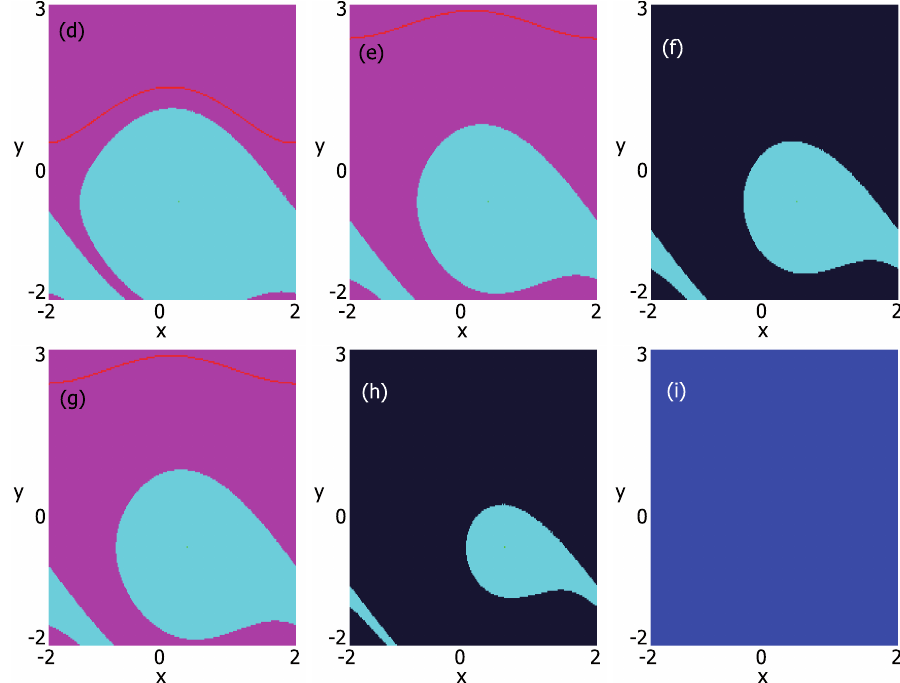
Figure 12. Plots of the basins of attraction of the vertically excited parametric pendulum with a torque. We use parameters ω = 3, α = 0.1, γ = 0.1, γ = 0.2 and γ = 0.3, from left to right respectively, and vary ν = 0, ν = 0.2 and ν = 0.4, from top to bottom respectively. As in the previous figure, we can observe the effect of varying the external torque by the changes observed in the basins ( a – i